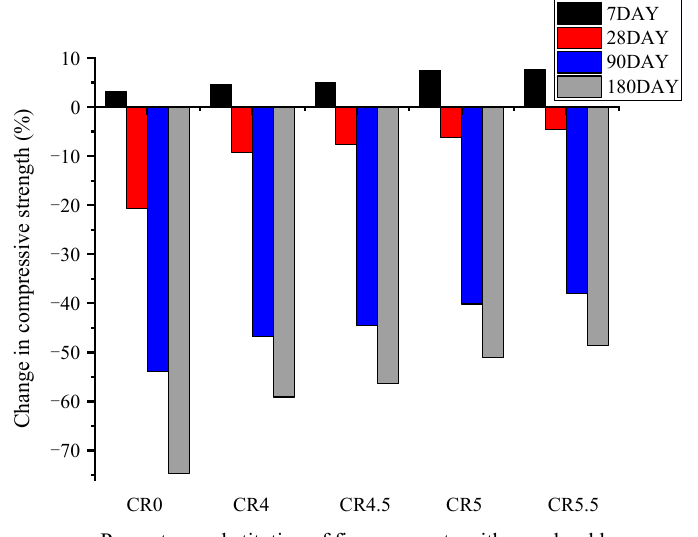
Percentage substitution of fine aggregate with crumb rubber Figure 10. Change in compressive strength after soaking in 3% H 2 SO 4 solution [108]. However, Rahimi et al. [111] reported that rubber incorporated into concrete reduced the resistance to H 2 SO 4 attack, which is contrary to conclusions of previous research. Azevedo et al. [86] found that adding rubber to HPC greatly reduced the H 2 SO 4 resistance. This phenomenon may be due to the increase in concrete permeability with the addition of rubber particles [112]. Using rubber fibre or rubber particles mixed with polyethylene terephthalate as fine aggregate could substantially increase the resistance to H 2 SO 4 attack [111]. Sulphate reacts with hydration products to produce ettringite, which expands in volume to generate internal compressive stress that forms cracks inside concrete and causes the internal structure of cement to peel off and cause structural damage [108]. Table 9 shows that using RA to replace part of natural aggregate can enhance the resistance to sulphate attack of concrete. In accordance with previous experience, the content and size of rubber particles affect sulphate resistance. Using CR (0–4.7 mm) to replaced fine aggregate partially with different substitution levels (10%, 20%, 30%, and 40% by volume); after sulphate attack, mass loss was reduced by 7.02%, 3.51%, 1.75%, and 22.81%, respectively, compared with the control group [73]. With the rubber content increases, the ability of concrete to resist sulfate attack increases. Figure 11 depicts the resistance to sulphate attack in self-consolidating rubberized concrete (SCRC) effected by particle sizes (#30: 0.6 mm, #50: 0.3 mm) and different rubber contents. The weight loss of RC is less than that of the control group in the rubber content of 5–10%. When the content exceeds 10%, the opposite situation occurs. The best resistance to sulphate attack is achieved when 5% rubber powder (passes through a #30 sieve) is incorporated